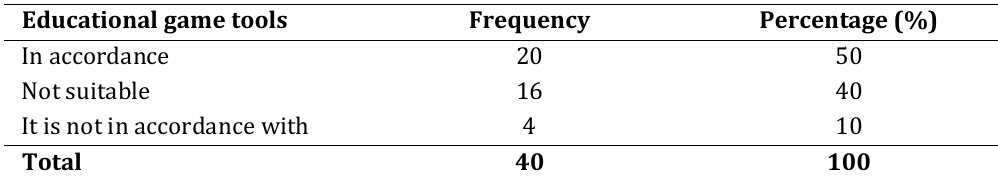
Characteristics of respondents the selection of educational games for preschool age children Educational game tools